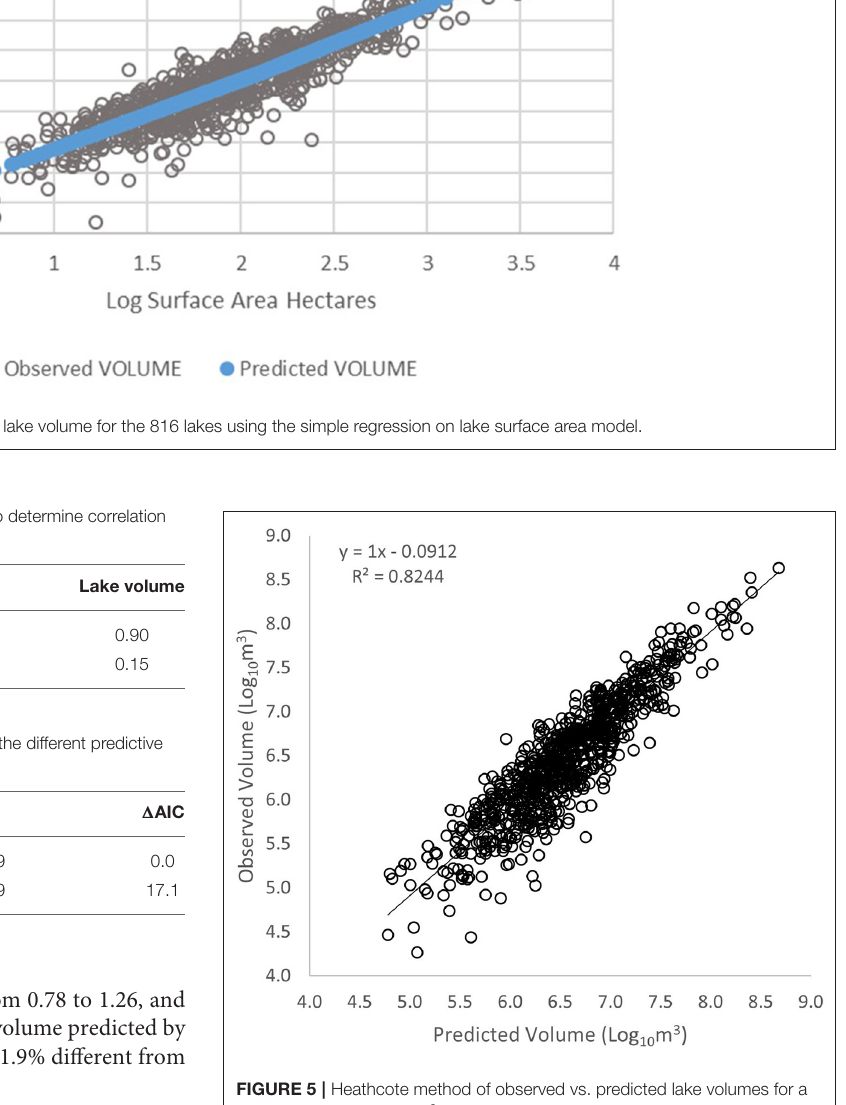
FIGURE 5 | Heathcote method of observed vs. predicted lake volumes for a linear regression model [ R 2 = 0.82, F (1,812) = 3,811, p < 2.2e −